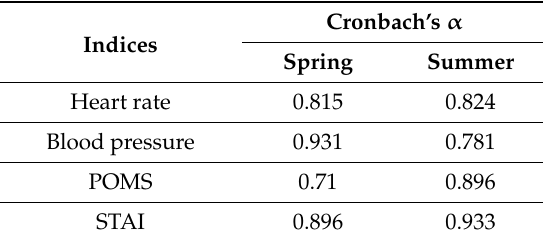
Table 4. Verification of internal consistency.